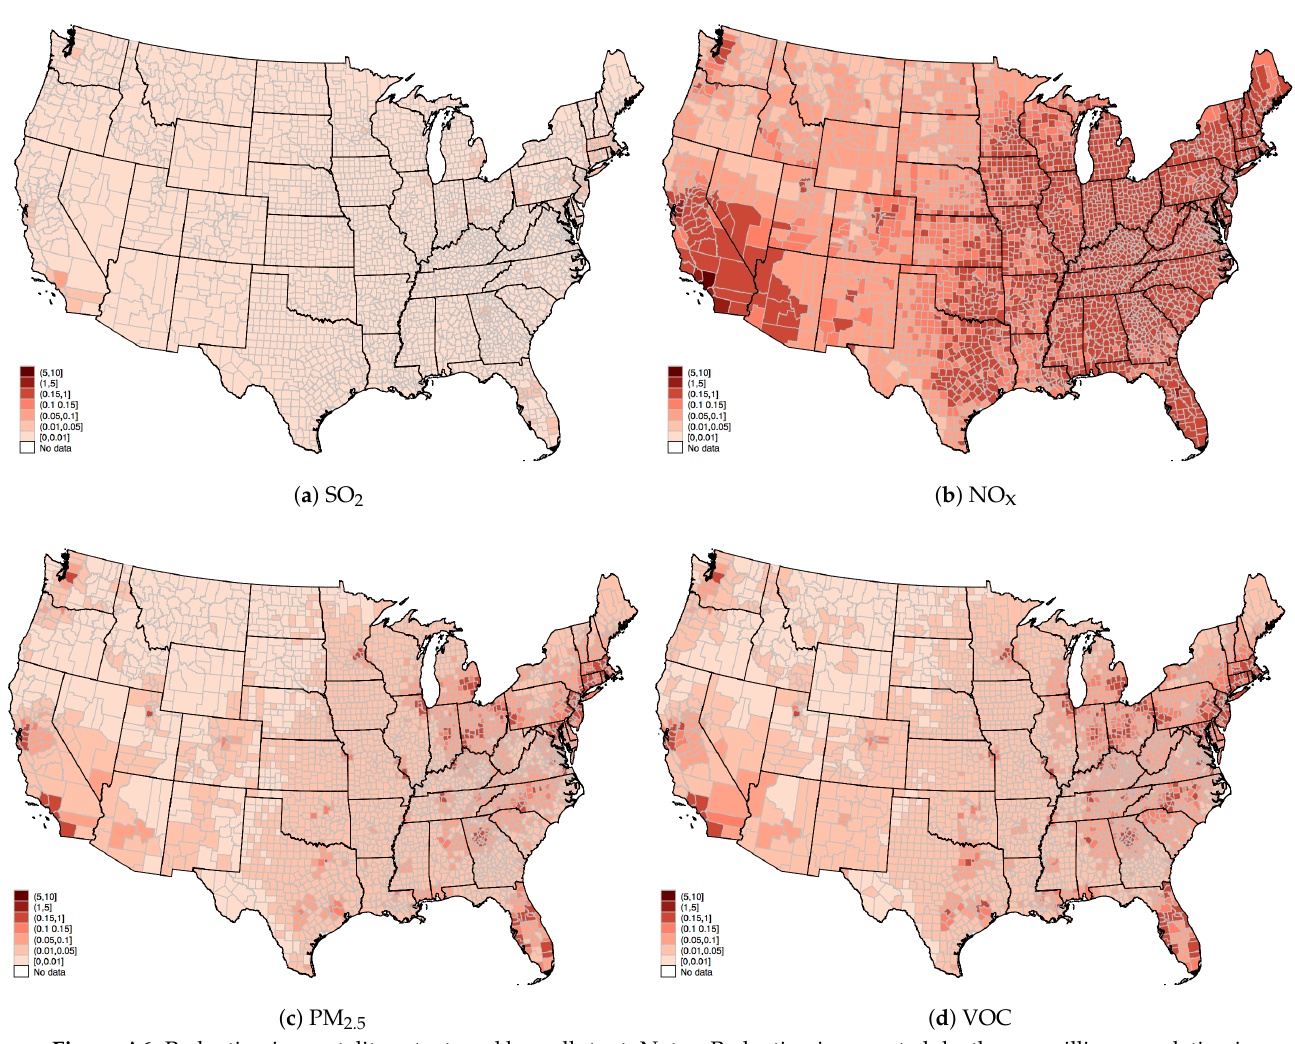
Figure A6. Reduction in mortality rate: travel by pollutant. Notes: Reduction in expected deaths per million population in a